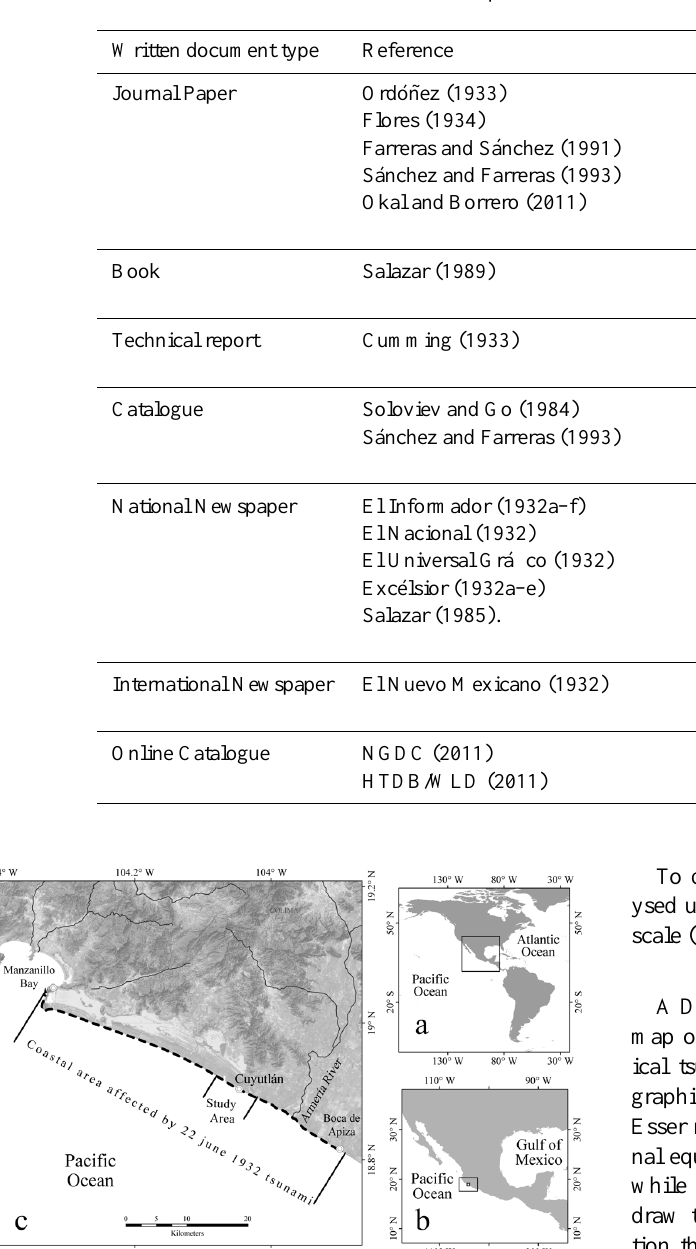
Table 1. Data source references and derived interview topics.